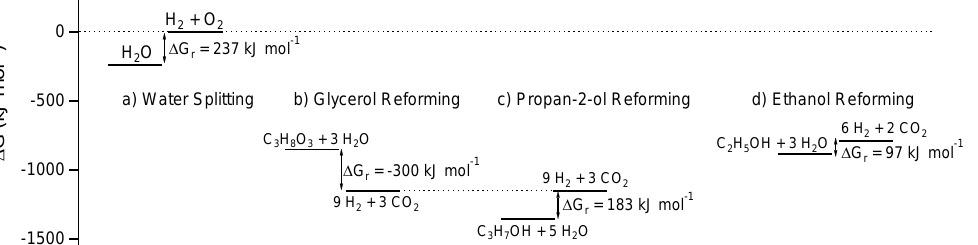
Figure 1. Energy diagram for water splitting and for the reforming of selected organic compounds.